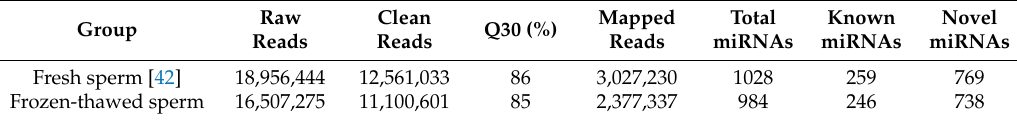
Table 1. Overview of small RNA sequencing in fresh and frozen-thawed boar sperm.